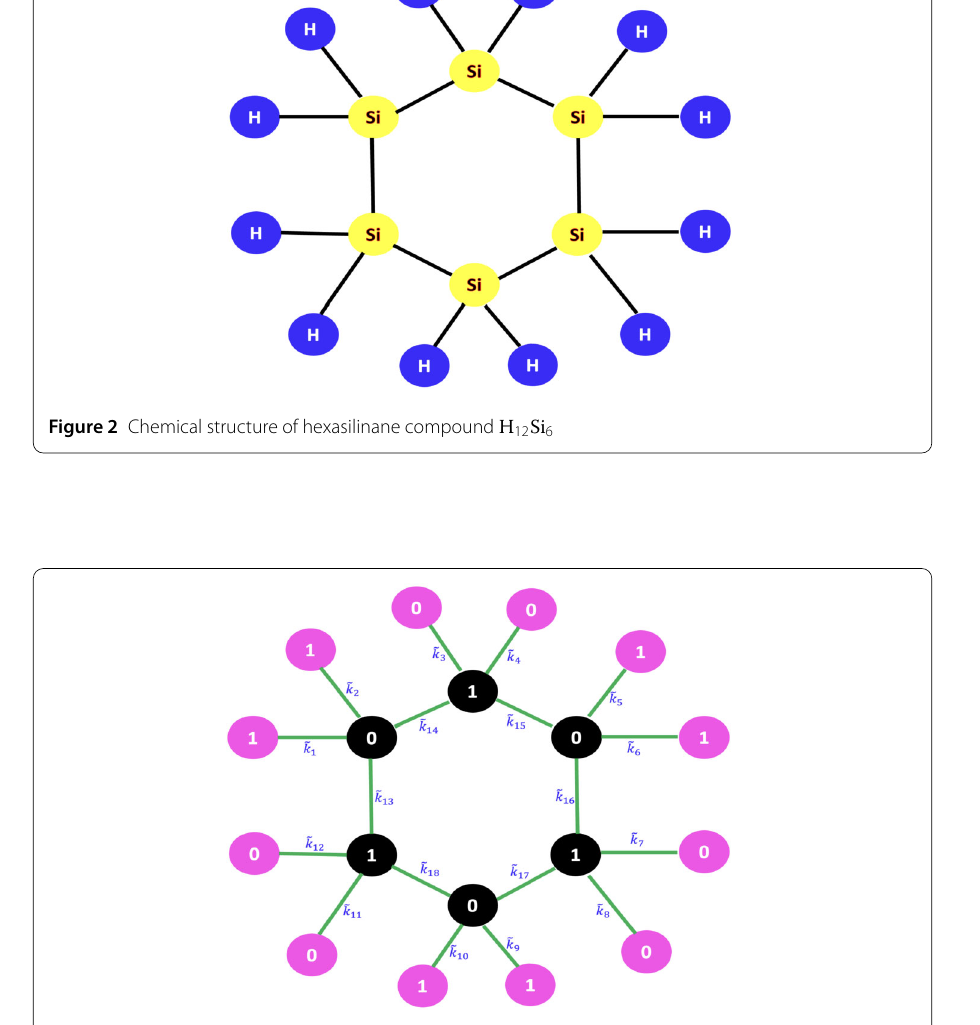
integral of order (cid:3) , the real functions β γ and q γ are defined on [ a , b γ ] ( γ = 1,2,..., n ), the functions S γ belong to L 2 ( a , b γ ), γ = 1,2,..., n , and the controls v γ , γ = 1,2,..., n , are real